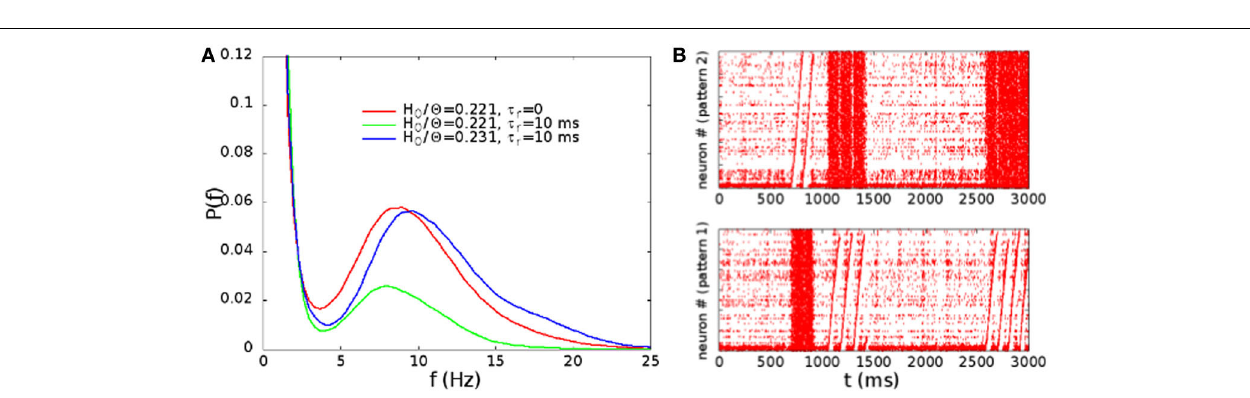
of the network with STSD, in the case of H 0 /(cid:4) = 0 . 231 and τ r = 10ms. Alternation of up and down states is similar to the case of Figure 4B